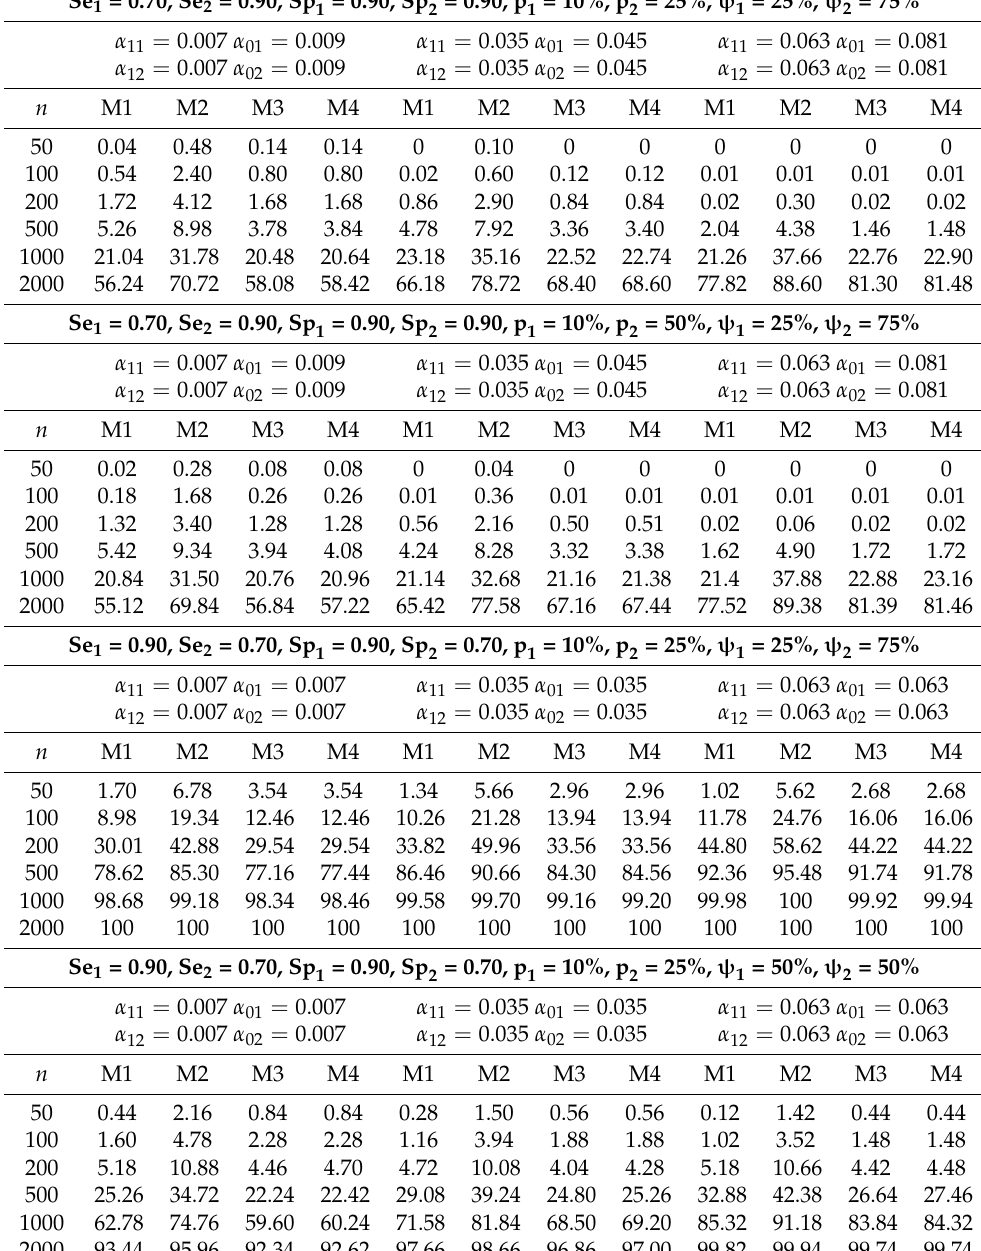
= { 0.70,0.90 } ) of two BDTs in the presence of a binary h